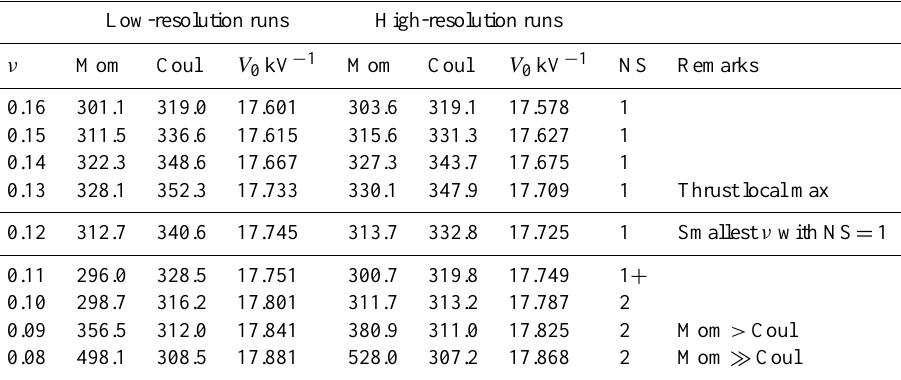
Table 2. Performed runs. Thrust per tether length in nNm − 1 by Mom and Coul methods, NS = number of shocks. The physically preferred run ν = 0 . 12 is singled out by horizontal